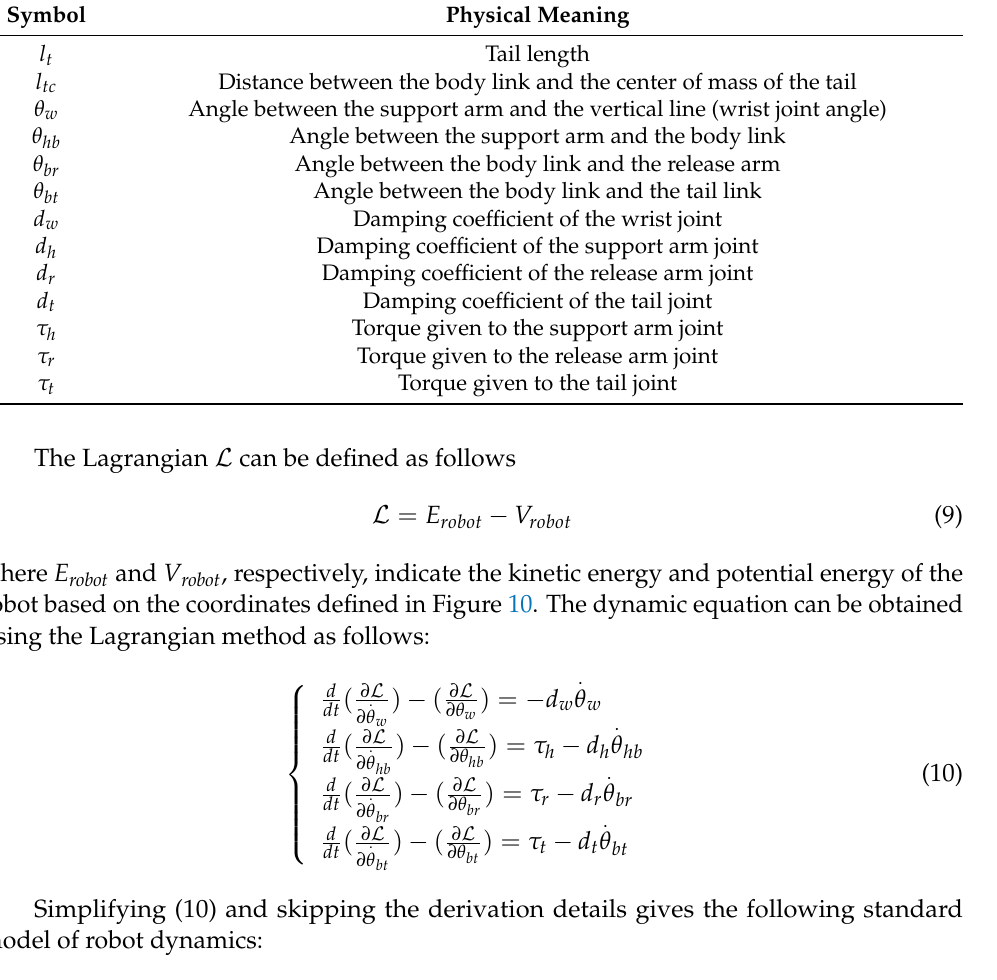
Table 2. Cont. Symbol Physical Meaning Tail length Distance between the body link and the center of mass of the tail Angle between the support arm and the vertical line (wrist joint